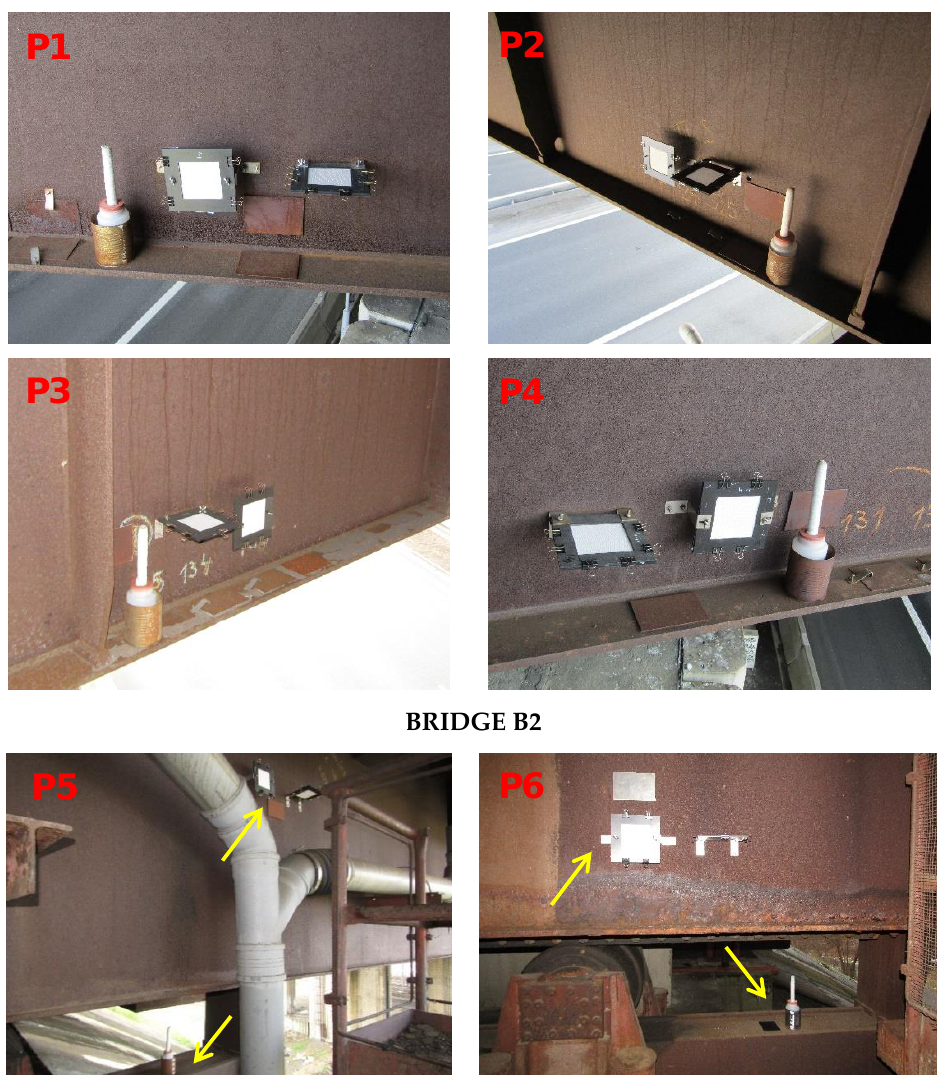
Figure 4. Selected positions for experimental testing on bridges B1 and B2.